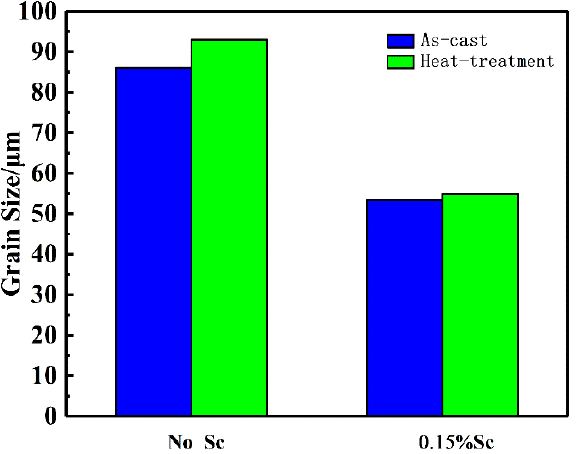
Figure 4. The average grain size of the alloy in different conditions.